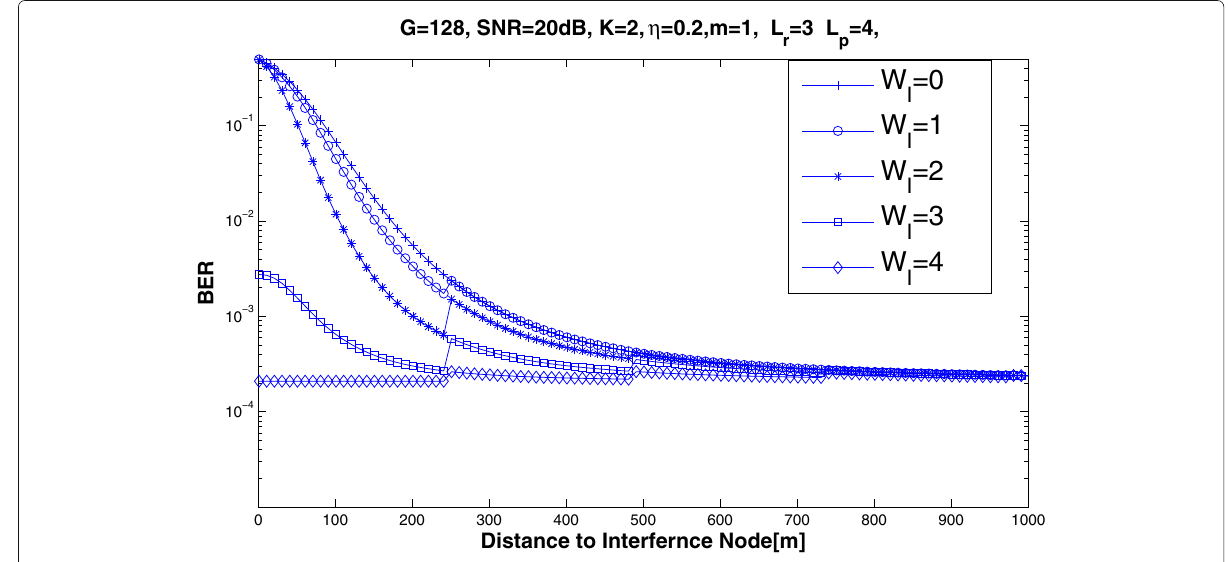
Fig. 5 BER vs distance of interference node in the cellular CDD communication system